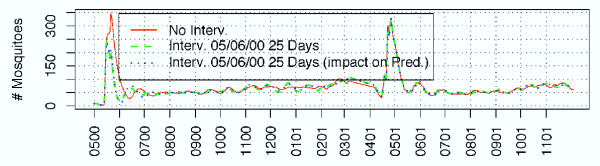
An. gambiae adult abundance with adult control intervention and predators